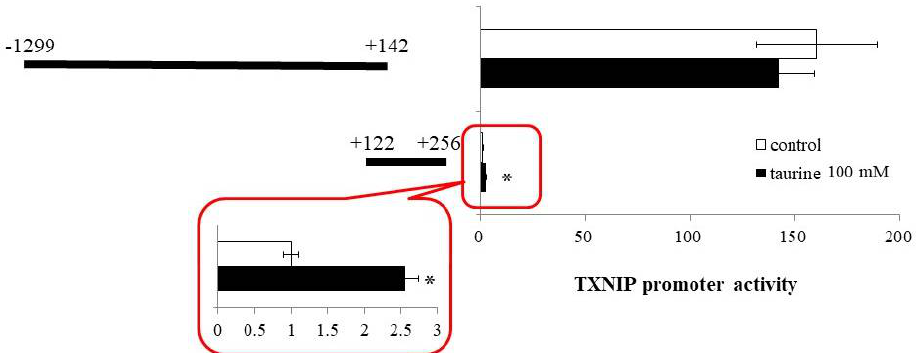
Figure 1. Effect of taurine on the transcriptional activity of the TXNIP promoter between −1299/+256. Caco-2 cells were transfected with a reporter vector containing partial promoter regions of TXNIP and then replaced with a medium containing 100 mM of taurine. After 24 h, the cells were subjected to a luciferase assay, as described in Materials and Methods Section 4.4. ( A ) TXNIP promoter partial sequences (−1299/+256, −109/+256, −39/+256). Results are expressed as relative values with the con- trol value of (−1299/+256) as 1. ( B ) TXNIP promoter partial sequences (−29/+256, −29/+142, −39/+65). Results are expressed as relative values with the control value of −39/+256 as 1. Each value represents the mean ± S.E. ( n = 3), * p < 0.05, vs. the control value (Student’s t -test).